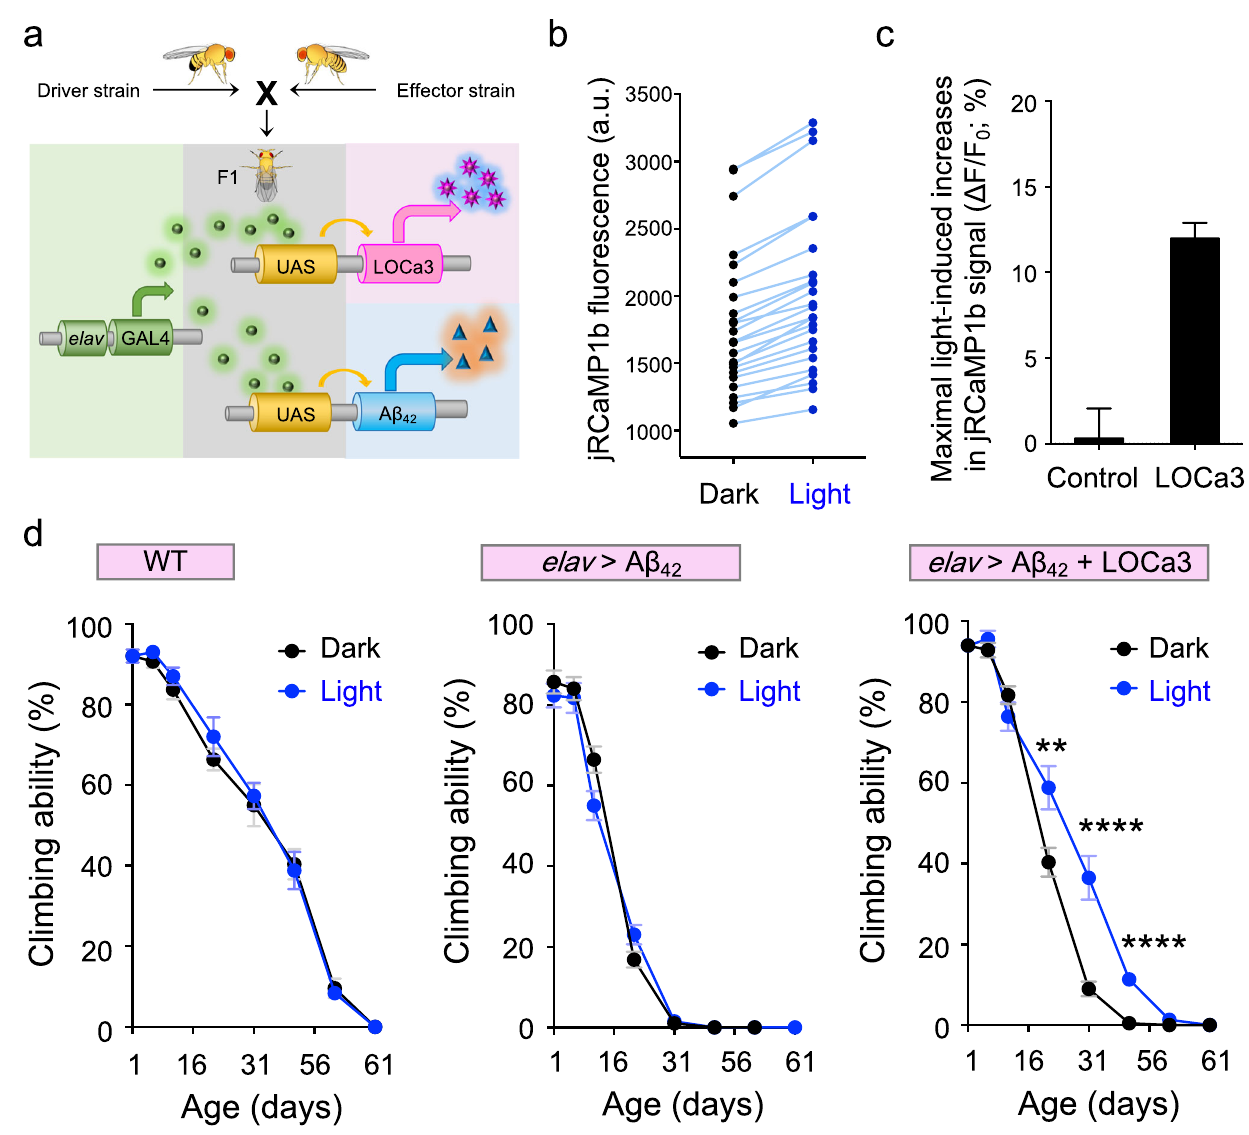
Fig. 4 LOCa3 enables optogenetic intervention in neurodegeneration in vivo. Data are shown as mean ± s.e.m. Blue light was delivered using pulsed LEDs emitting at 470 nm with a power density of 40 µ W/mm 2 . Flies were subjected to a total of 10 min photostimulation per hour for up to two months. a Diagram showing the generation of AD fl ies expressing A β 42 and /or LOCa3 by using the GAL4-UAS expression system, with the driver stain bearing GAL4 under the control of a Drosophila neuron-speci fi c Elav (embryonic lethal abnormal visual system) promoter to enable pan-neuronal expression of target genes. b Statistics showing jRCaMP1b fl uorescence within the same regions of the brain from LOCa3-expressing AD Drosophila before and after exposure to blue light ( n = 24 from 5 fl ies). c . Quanti fi cation of changes of jRCaMP1b fl uorescence before and after light stimulation in the brains of AD fl ies and AD fl ies co-expressing LOCa3 ( n = 5 fl ies each). d Graphs showing the effects of photostimulation on the climbing ability during aging in WT (left panel), A β 42 (middle), and A β 42 + LOCa3 (right) fl ies (5 independent replicates; 10 fi les per repeat). ** P = 0.0046; **** P < 0.0001 (compared to the dark group; two-tailed unpaired Student ’ s t -test). Also see Supplementary Movies 2 –